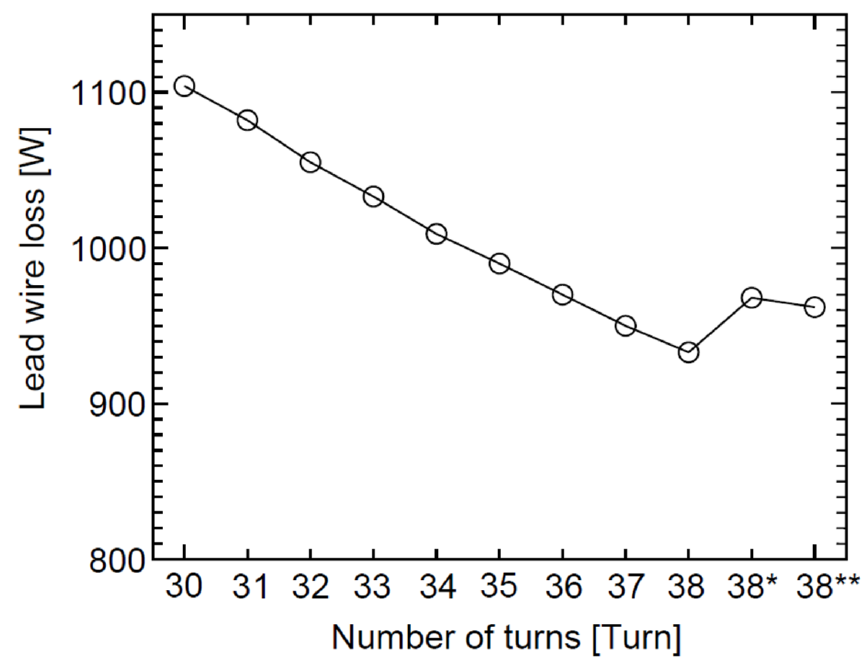
Figure 6. The lead wire loss when the secondary winding changes.